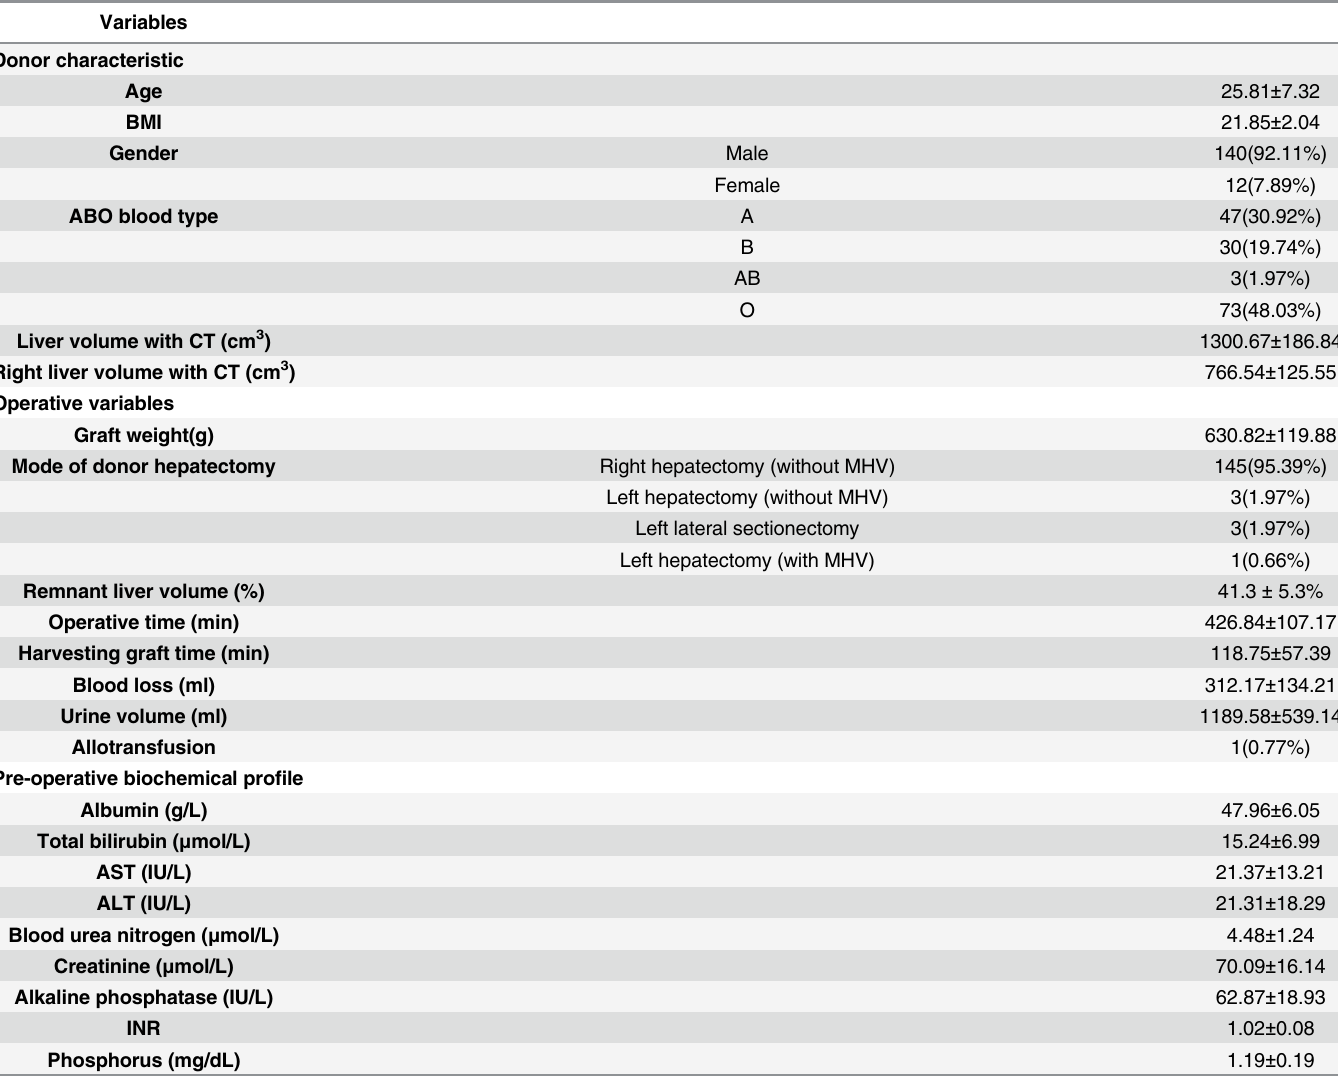
Table 2. Pre-operative and operative characteristics of 152 living liver